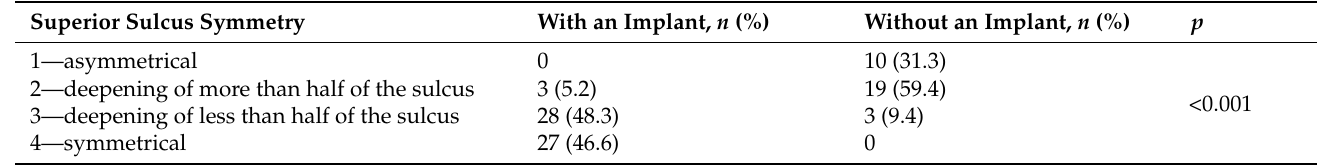
Table 3. Assessment of superior sulcus symmetry in patients with and without an orbital implant.